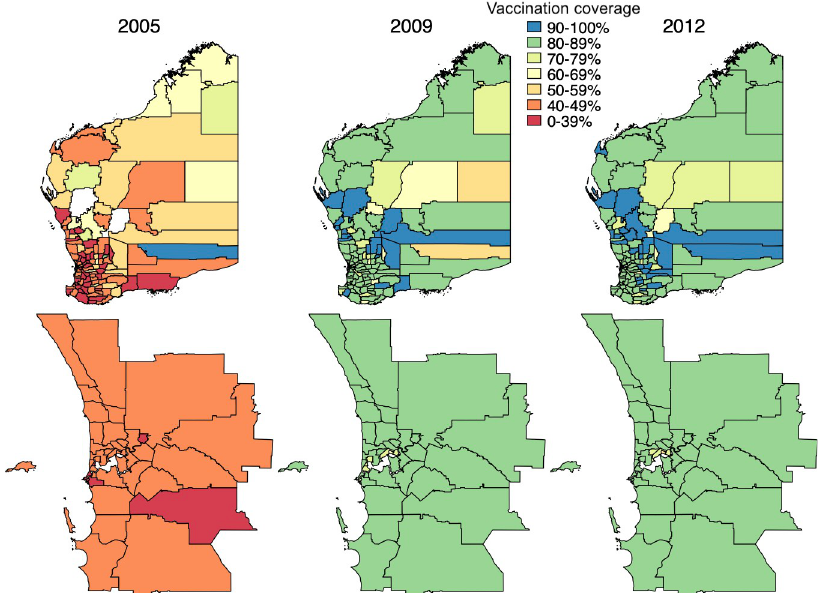
Fig 3. Coverage � of any PCV among children 12–23 months of age by SLA and year, Western Australia, 2001– 2012; top row: Western Australia (state), bottom row: Perth (capital city); SLAs coloured white have been excluded due to small numbers of children. � Vaccinated defined as 2 or more PCV doses administered at < 12 months of age or at least 1 PCV dose administered after the age of 12 months. SLA digital boundaries (ASGC 2006) for this map were obtained from the Australian Bureau of Statistics (https://www.abs.gov.au/) CC BY 4.0. PCV, pneumococcal conjugate vaccine; SLA, statistical local area.